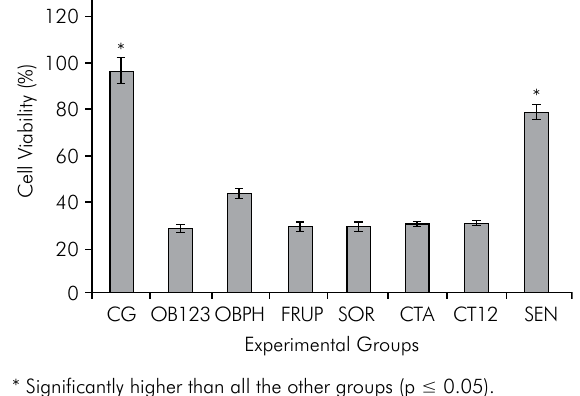
Figure 2. Cell viabilities (% ± standard error of the mean) in the experimental time period of 24